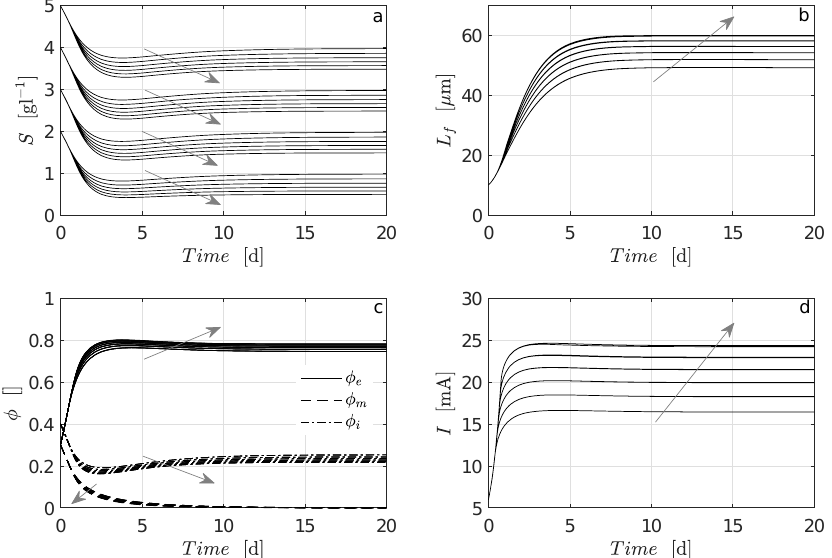
(Figure 2b), exoelectrogenic microorganism fraction (Figure 2c), and current (Figure 2d) are obtained when higher voltage is applied. In contrast, smaller values are obtained for the mass fraction of methanogenic microorganisms (Figure 2c) when higher voltages are applied.